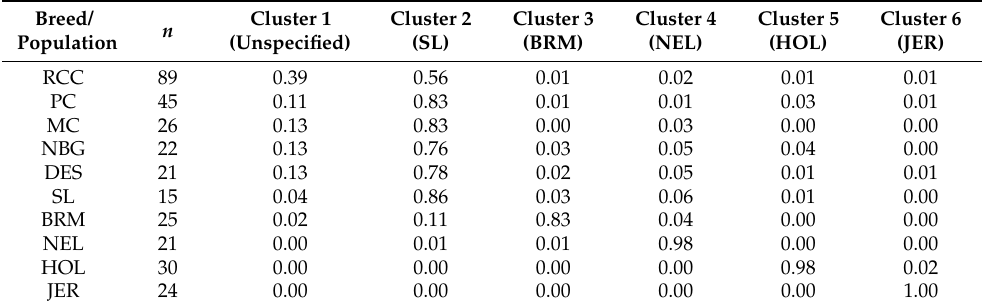
Table 2. Genetic composition of six cattle populations of Bangladesh compared with indicine and taurine breeds using the ADMIXTURE software.